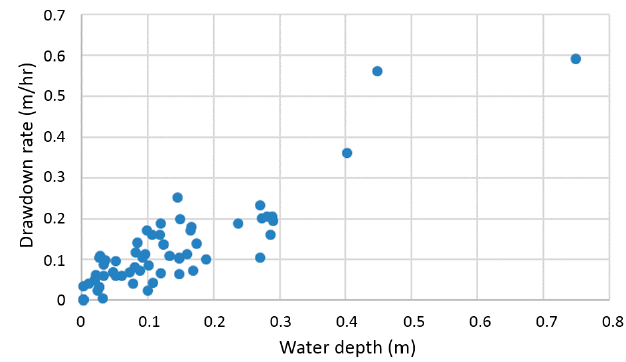
Figure 9. Comparison of maximum drawdown rate vs water depth in the infiltration bed of all events including the simulated runoff test.